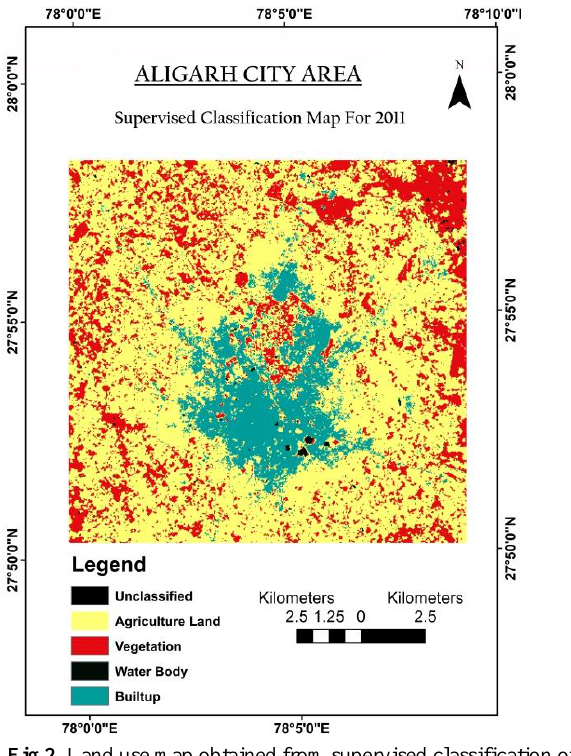
Fig 2 . Land use map obtained from supervised classification of 2011 Landsat TM imagery.